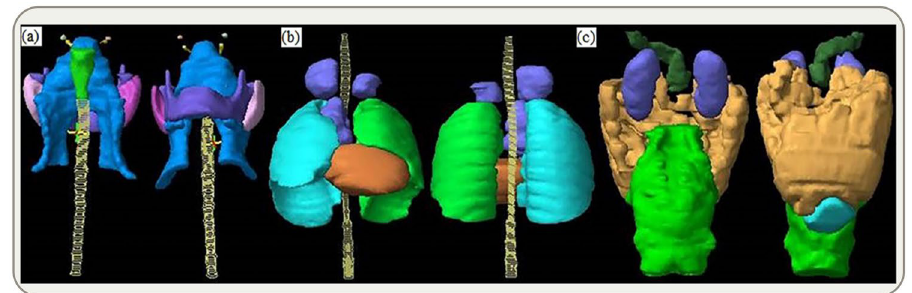
Figure 5. Radiation oncologists delineate PTVs and OARs on CT images. ( a ) PTVs are in blue, while the remaining colors indicate OARs; ( b ) PTVs are in light coffee, while the remaining colors indicate OARs; (c) PTVs are in light brown, while the remaining colors indicate